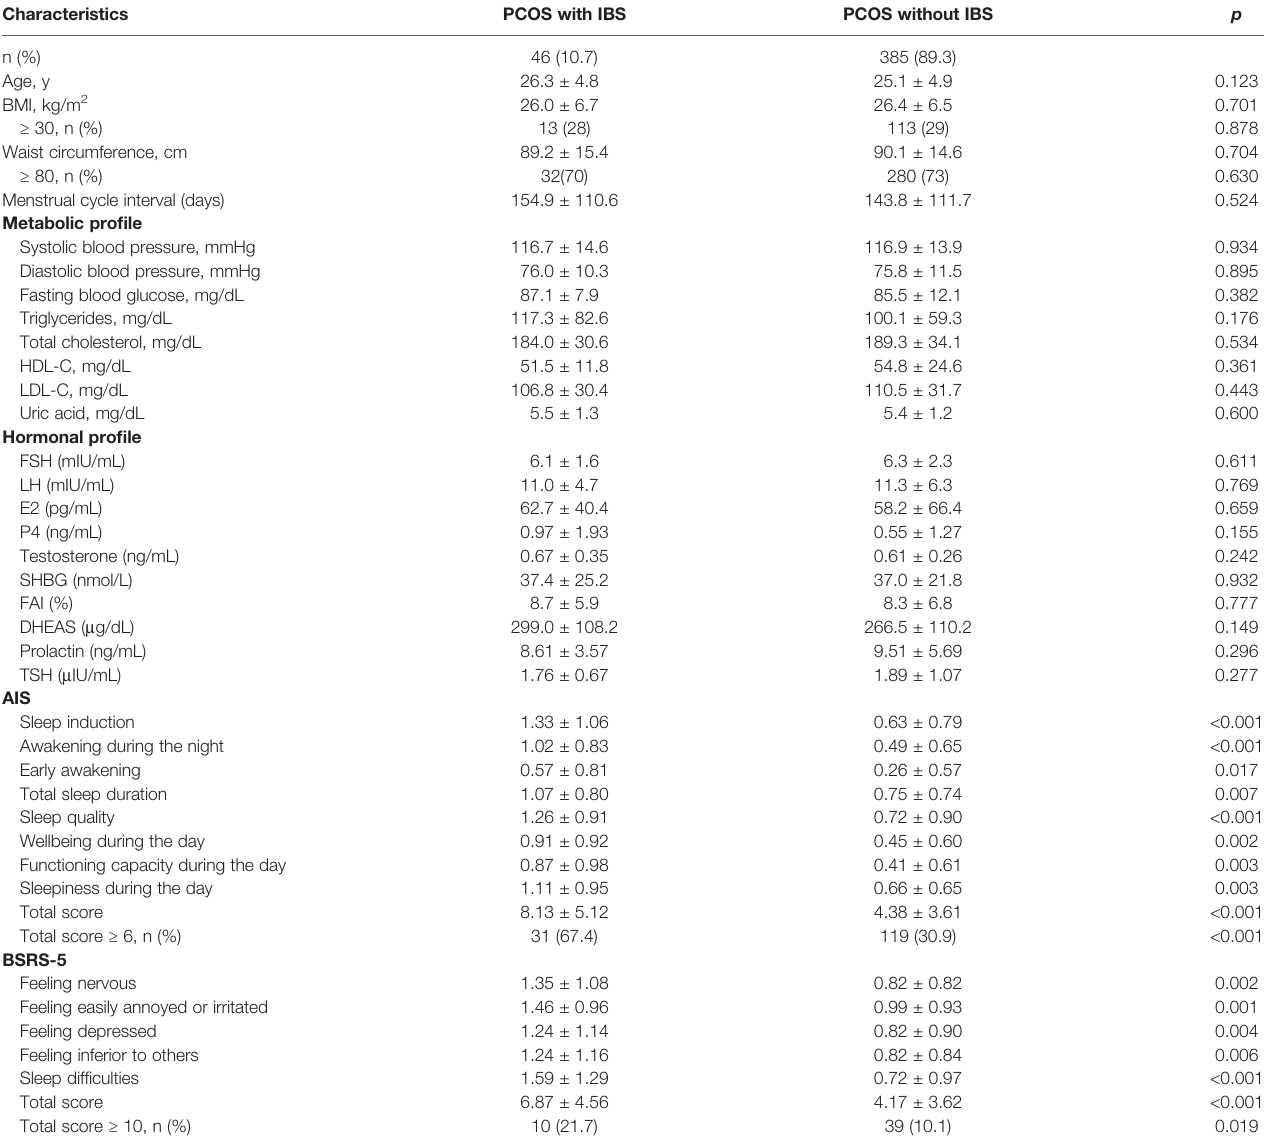
TABLE 3 | Anthropometrics, laboratory, and sleep and psychological characteristics in PCOS patients with and without IBS. Characteristics PCOS with IBS PCOS without